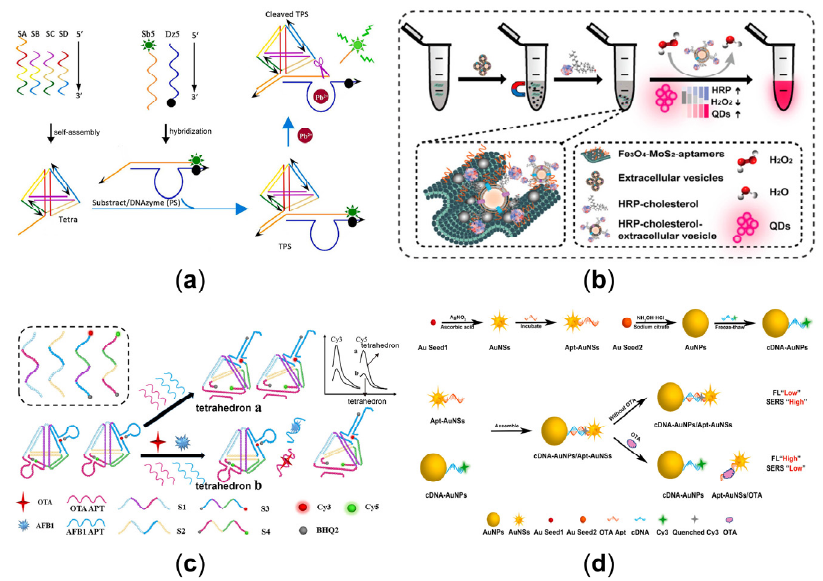
Figure 6. ( a ) Tetrahedron-based Pb 2+ -sensitive DNAzyme sensor (TPS) that combines GR-5 DNAzyme with DNA tetrahedral [131]. (Reprinted from Talanta , Guan, H.; Yang, S.; Zheng, C.; Zhu, L.; Sun, S.; Guo, M.; Hu, X.; Huang, X.; Wang, L.; Shen, Z. DNAzyme-based sensing probe protected by